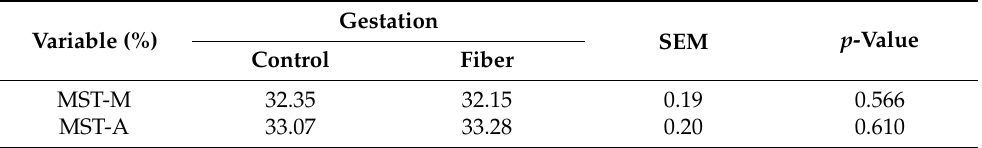
Table 8. Mean body surface temperature ( ◦ C) in the morning (MST-M) and the afternoon (MST-A); mean temperature ( ◦ C) of pregnant sows with or without supplementation of dietary fiber in the diet.